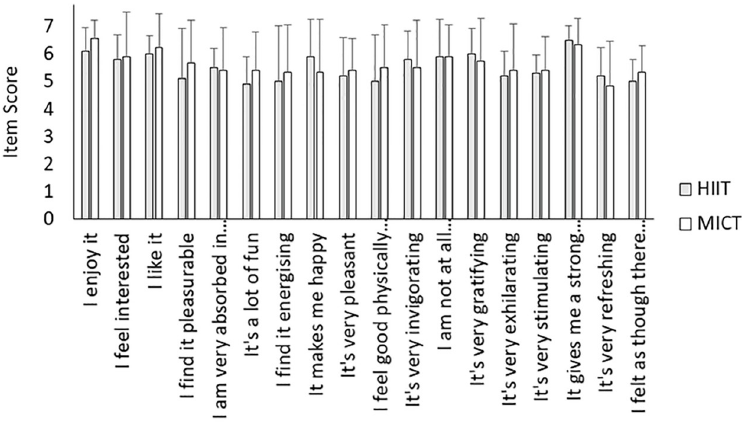
Fig 5. Mean (SD) single item scores (from 1 to 7) for PACES for both HIIT and MICT